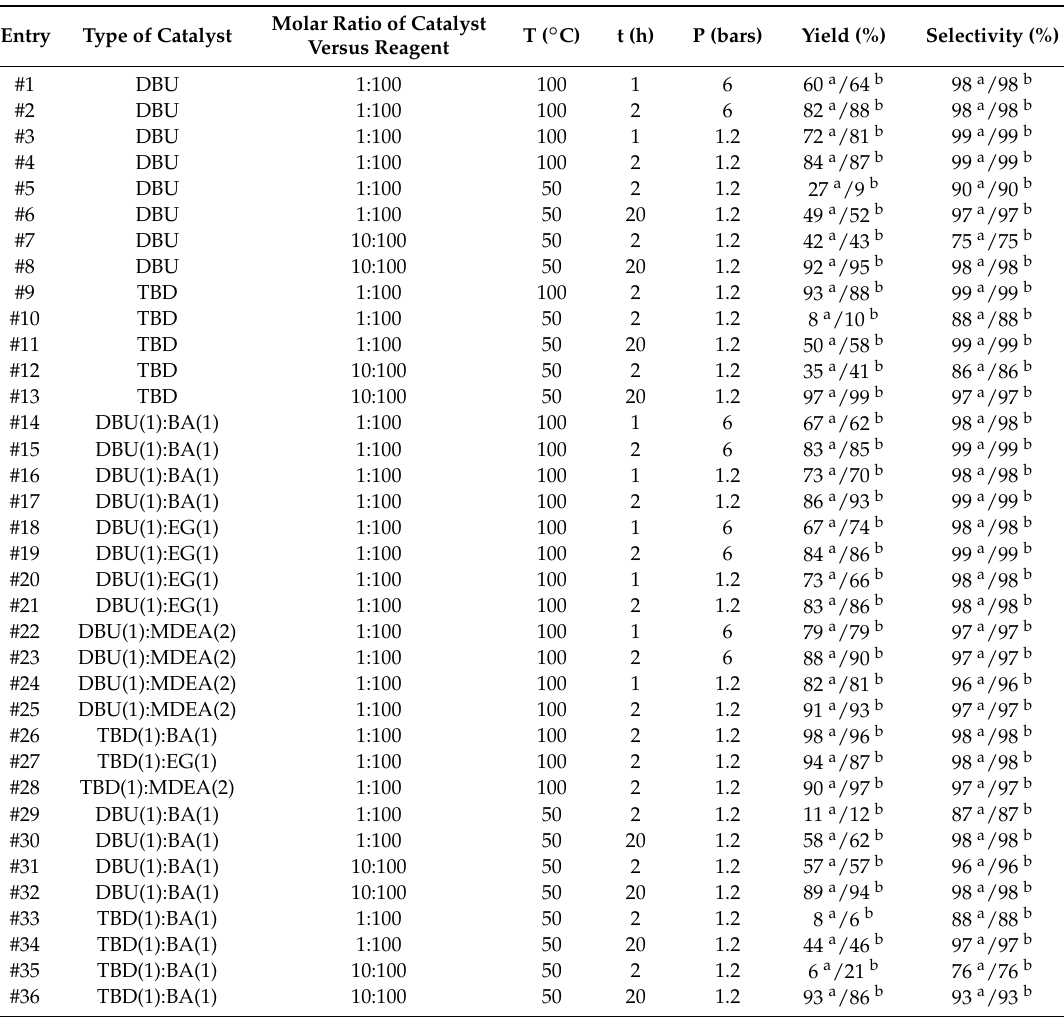
Table 2. Yield and selectivity found for the chemical fixation of CO 2 into EP using DBU and TBD, in either their bare form or in the form of DES, as catalysts and different experimental